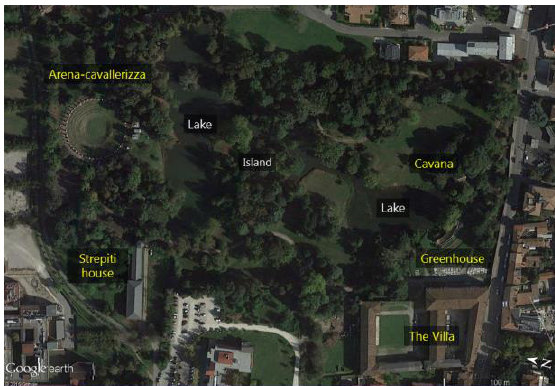
Figure 2: Aerial view of Villa Revedin-Bolasco and the Park